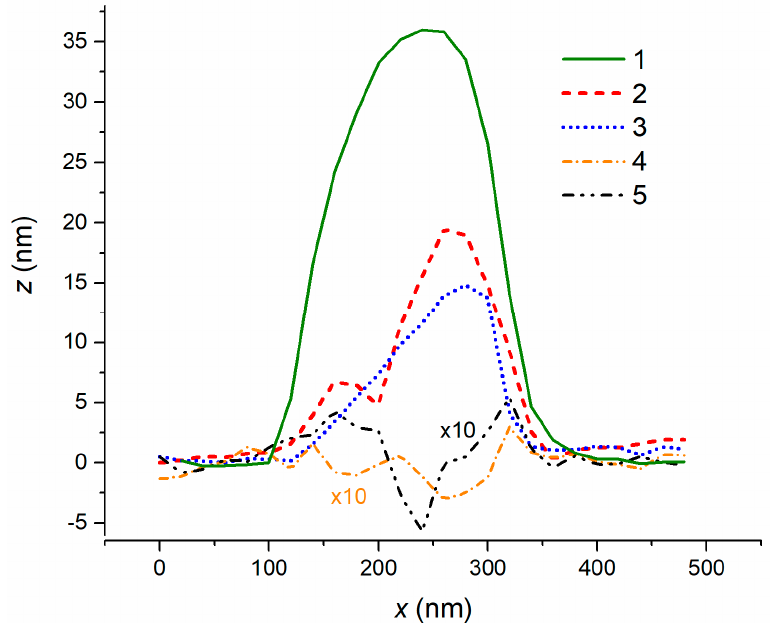
Figure 5. AFM profiles of nanostructures obtained after the deposition of 1.5 ML of indium and further exposure to the ultra-low arsenic flux: ( 1 ) P/P 0 = 1; ( 2 ) P/P 0 = 1.4; ( 3 ) P/P 0 = 2; ( 4 ) P/P 0 = 4; ( 5 ) P/P 0 = 8.1.